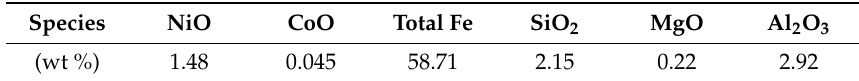
Table 1. Analysis of the dried limonitic ore.